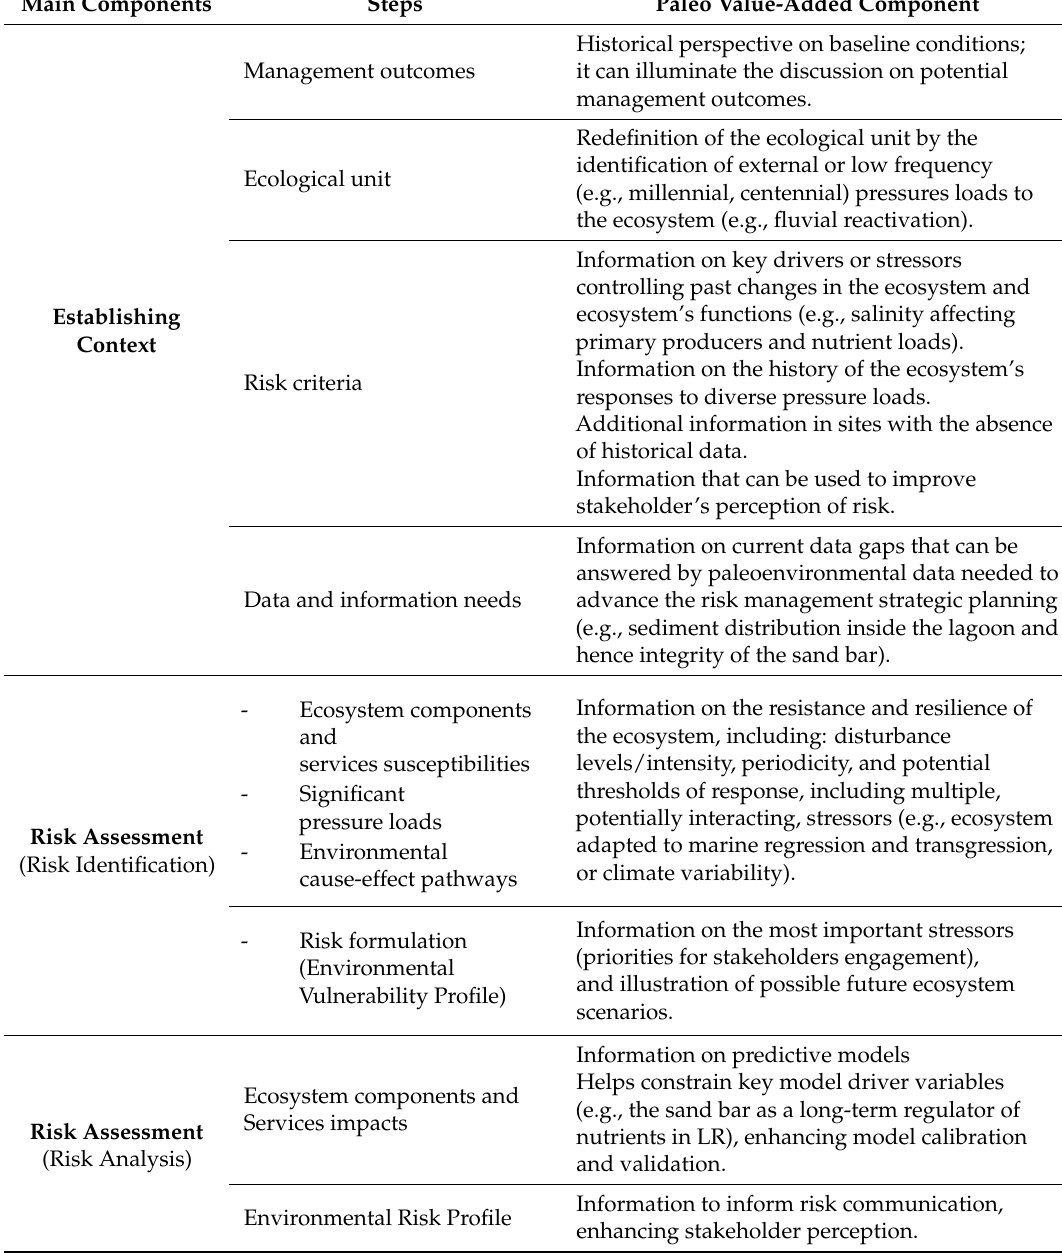
Table 1. Summary of the main contributions of paleo-data into the EBRM